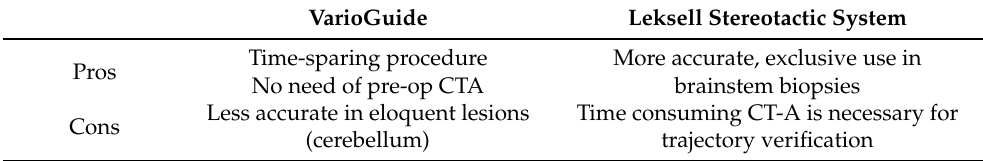
Table 4. VarioGuide vs. LSS